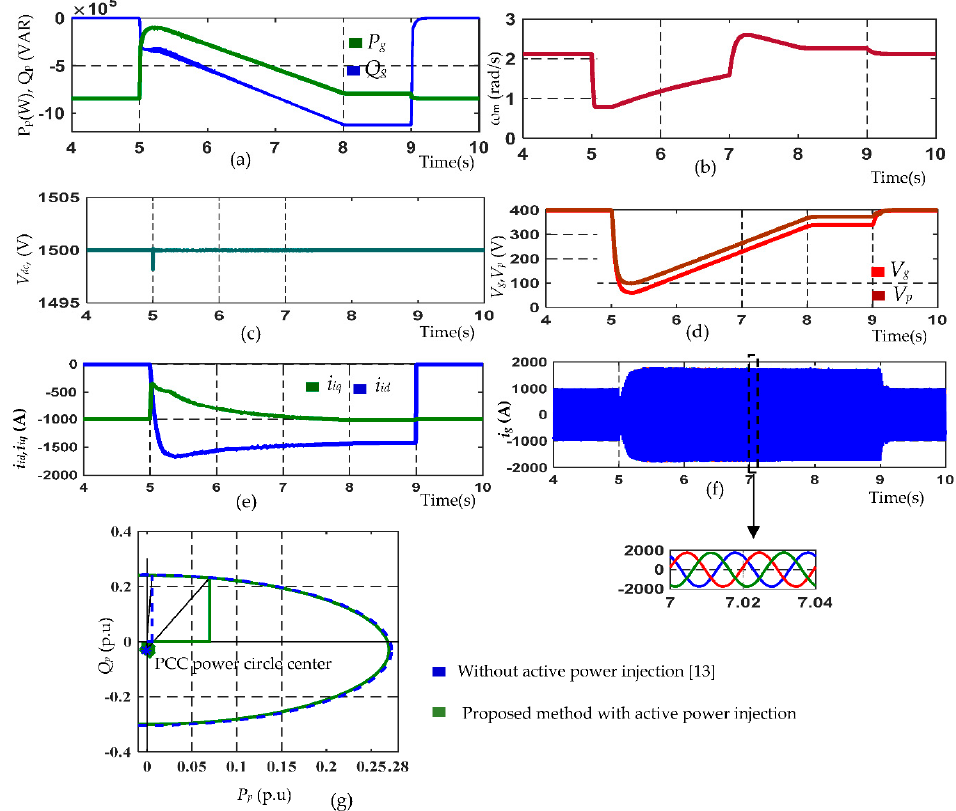
Figure 6. Performance analysis during symmetrical fault: ( a ) grid active (W) and reactive power (VAR); ( b ) PMSG speed, rad/s; ( c ) DC-link voltage (V), ( d ) PCC phase voltage (RMS), (V); ( e ) grid current in d-q frame, (A); ( f ) grid current in abc axis, A. Where the dashed square represents the zoomed-in view for the period from 7 ms to 7.04 ms; and ( g ) PCC end Power circle during 85% voltage sag.